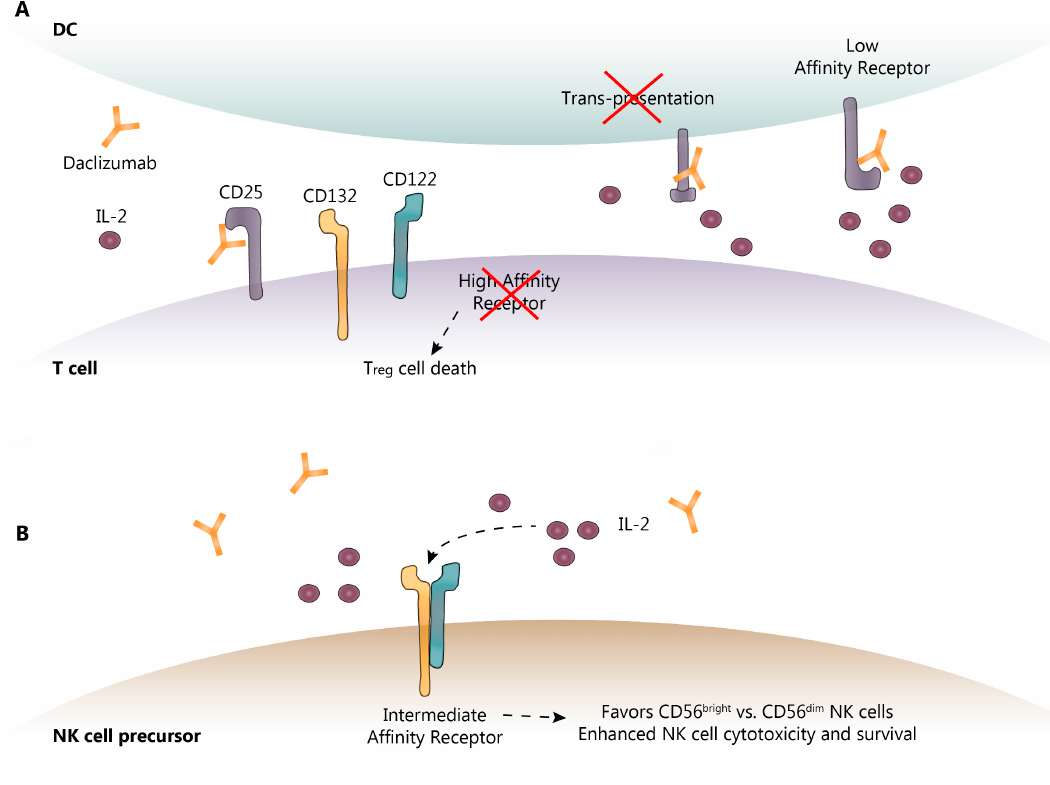
Figure 2. Known and proposed DAC mechanisms of action. ( A ) DAC binds to CD25 blocking its association with CD132 and CD122. This prevents trans-presentation of CD25 from mDC to T cells and ultimately results in effector T cell and T reg cell death; ( B ) As a result of CD25 blockade, serum IL-2 levels are elevated allowing for NK cell activation through the intermediate-affinity receptor, CD132 and CD122, and promoting CD56 bright NK cell cytotoxicity and survival. DC-dendritic cell; IL-2-interleukin-2; NK-natural killer. Dotted lines show the sequence of events following IL-2 binding to its